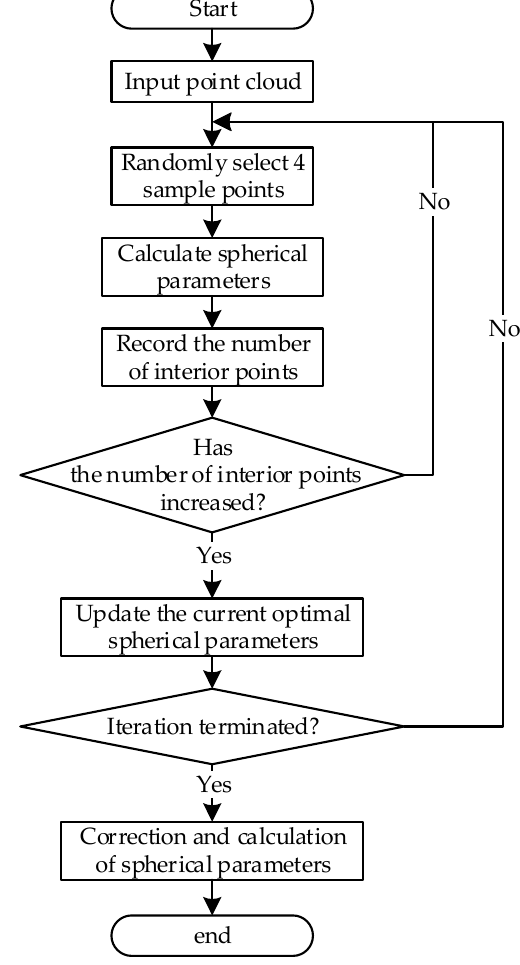
Figure 6. Flowchart of sphere fitting algorithm using RANSAC.